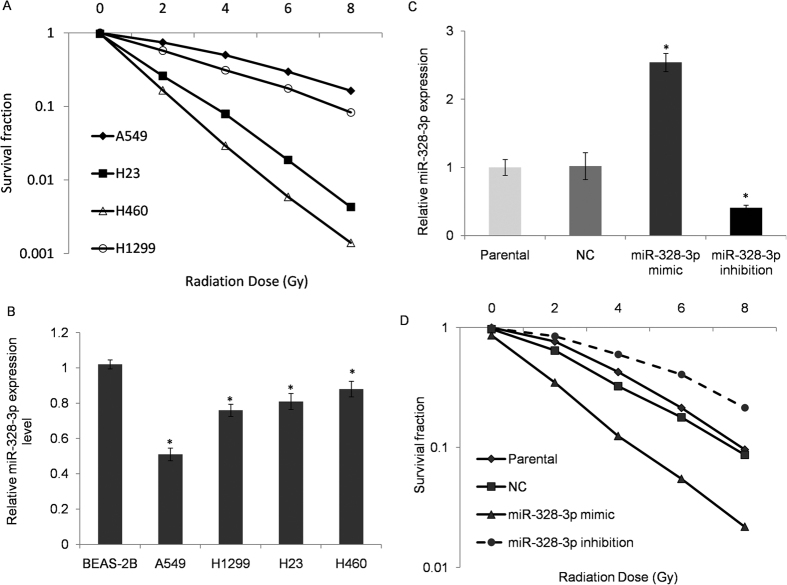
Comparison of the inner radiosensitivity and miR-328-3p expression in NSCLC cell lines.(A) Four NSCLC cell lines A549, H1299, H23 H460 and non-cancerous bronchial epithelial cells BEAS-2B were irradiated with a 0, 2, 4, 6, or 8 Gy and were performed with colony formation assay. Innate radio-sensitivity was observed as followed: A549>H23>H1299>H460. (B) miRNA-328 expression in four NSCLC cell lines was detected using the qRT-PCR. U6 served as an internal control. Relatively decreased expression of miR-328-3p was globally observed in all cell lines compared to normal epithelial cells. *p < 0.05. Results presented as the mean ± SEM of the values obtained in 3 independent experiments. (C) Transfection efficiency of miR-328-3p mimic and inhibitor verified with the RT-PCR. *p < 0.05 as compared to the negative control. (D) Irradiation response of A549 cell following transfection with a miR-328-3p mimic, inhibitor or control. miR-328-3p mimic sensitive cell response to irradiation; miR-328-3p inhibitor attenuated this effect.